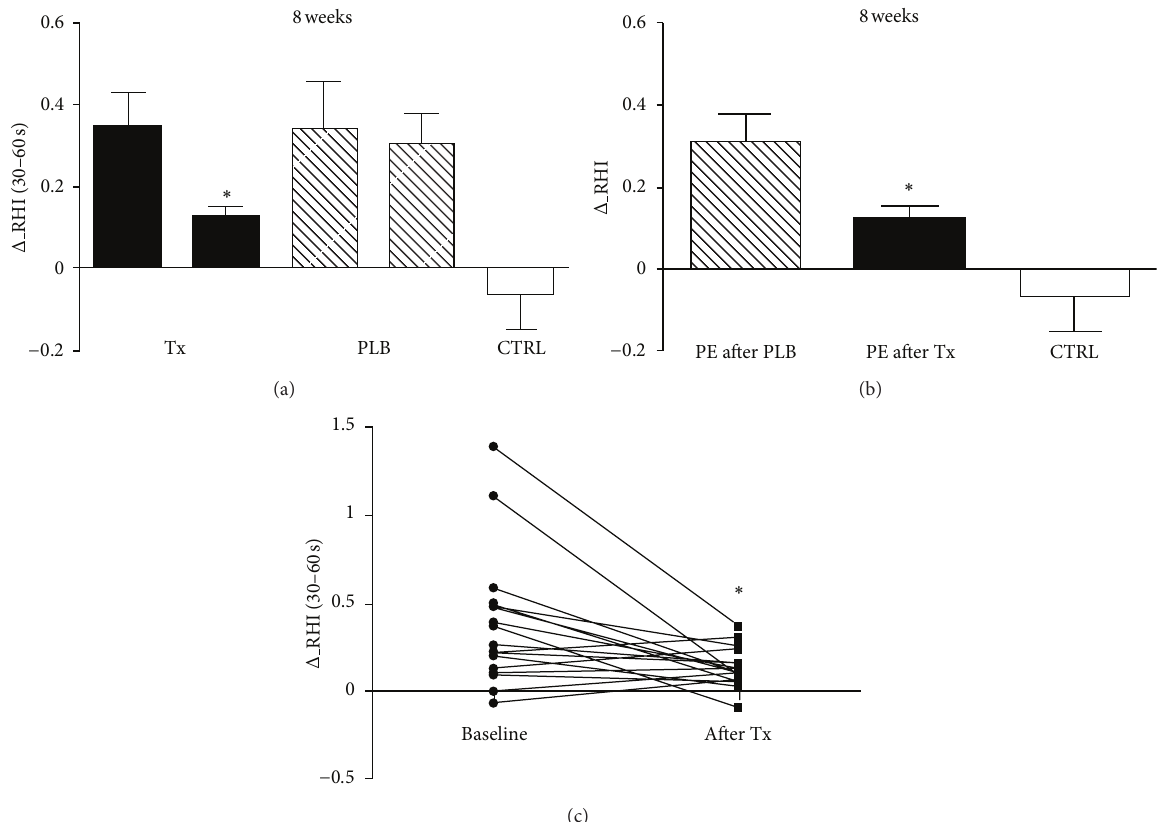
Figure 4: Variations in delta RHI values after 8-week double-blind controlled trial. Tx = active treatment. PLB = placebo treatment. CTRL = controls.